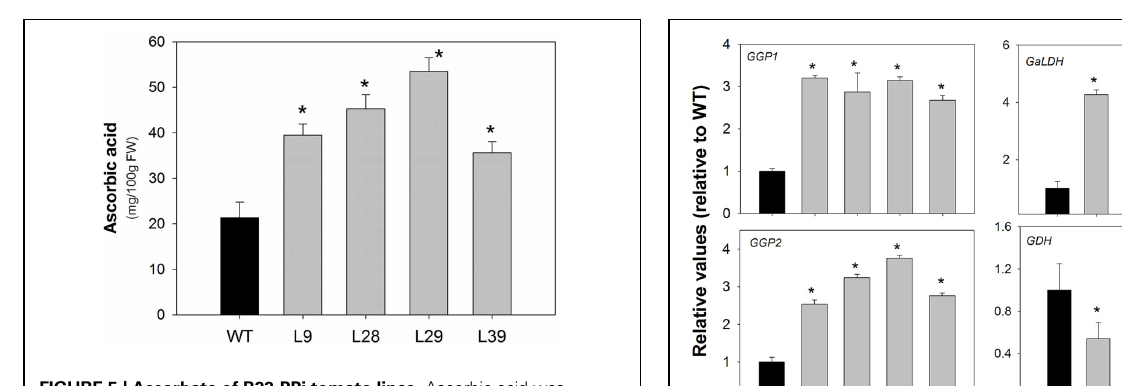
expressing a bacterial pyrophosphorylase or a yeast